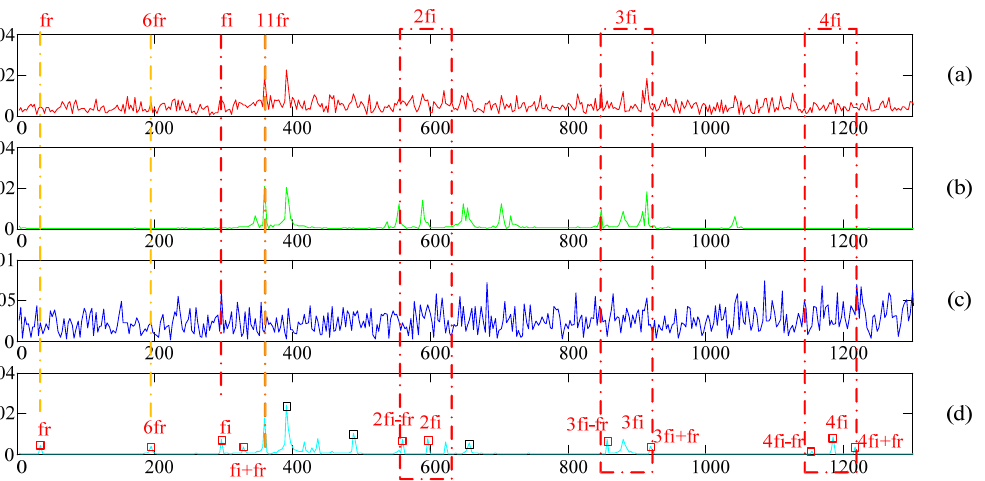
Figure 11. Time and frequency domains of the sixth channel signal.